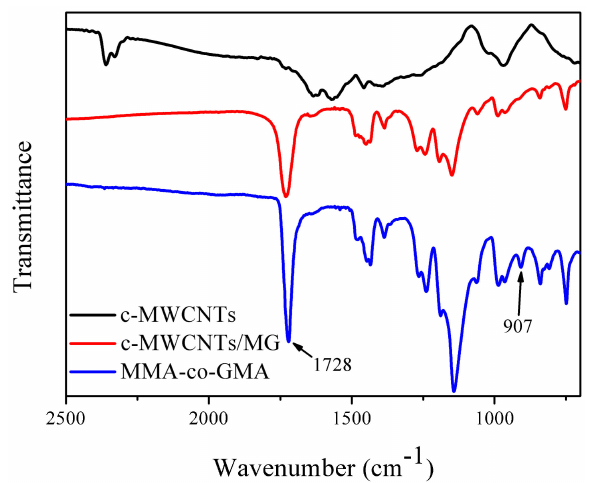
Figure 2. Fourier transform infrared spectroscopy (FTIR) spectrum of pristine c-MWCNTs, MG copolymers, and c-MWCNTs/MG composites.